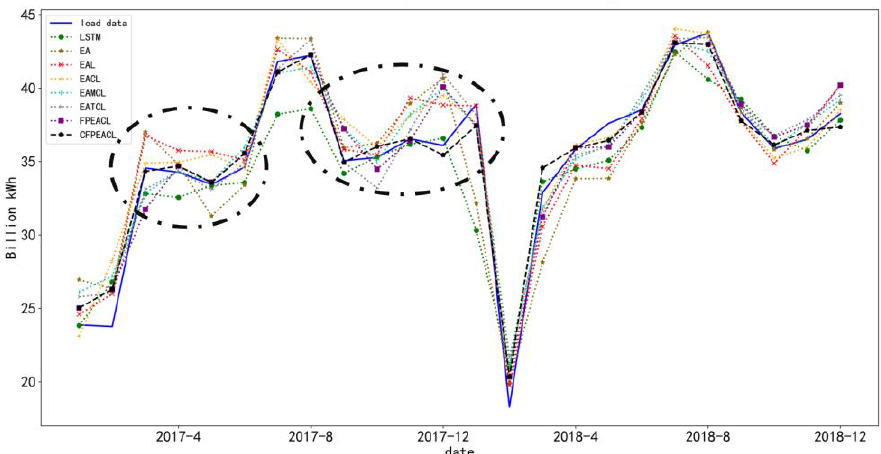
Figure 8. Comparison of annual initial monthly load forecasting results between FPEACL and other models.